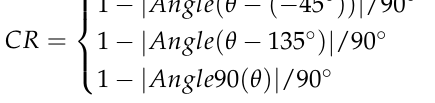
Figure 3. Location and subregions of Henan province.